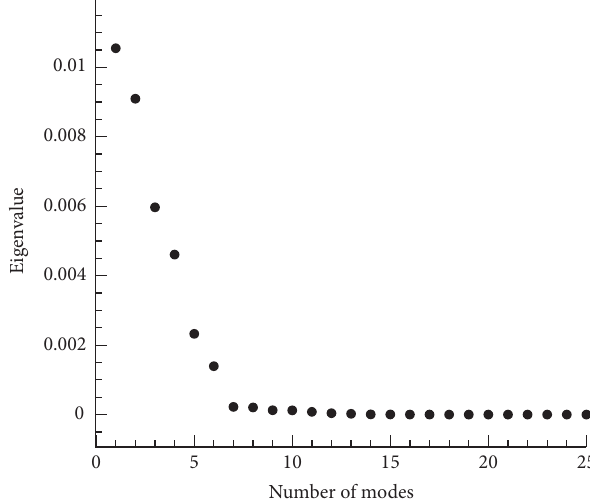
Figure 1: The eigenvalue with the number of